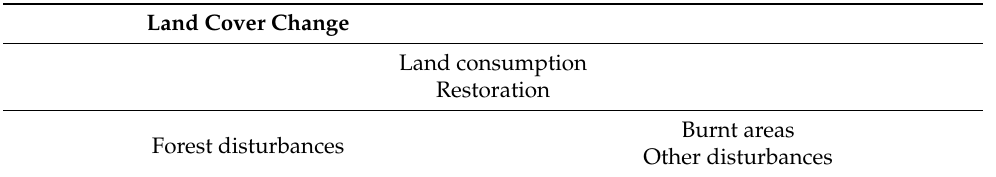
Table 2. Land cover change classification